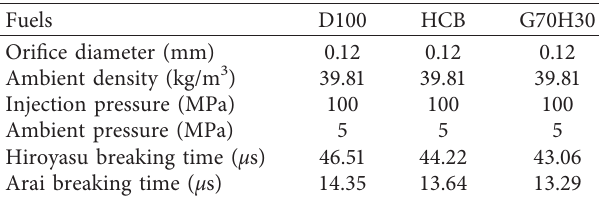
Table 4: Break time of experiment